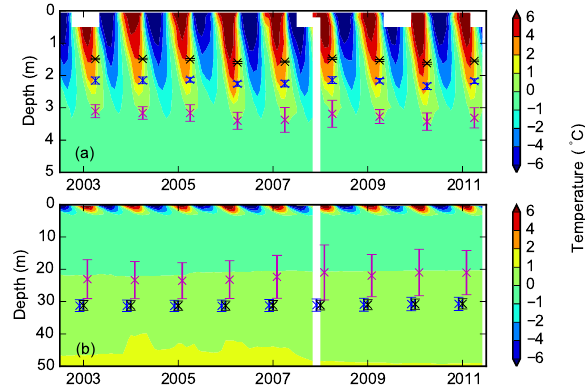
Figure 7. Comparisons of soil volumetric liquid water content ( θ liq , m 3 m − 3 ) simulated using default parameters sand, default loam, and measured parameters (lines) with measured soil moisture (dots) at 10, 40, 80, and 160cm depths. Error bars showed the standard deviation calculated based on nine simulations with three differ- ent slopes and three different soil thicknesses (measured porosities were used in the simulation).